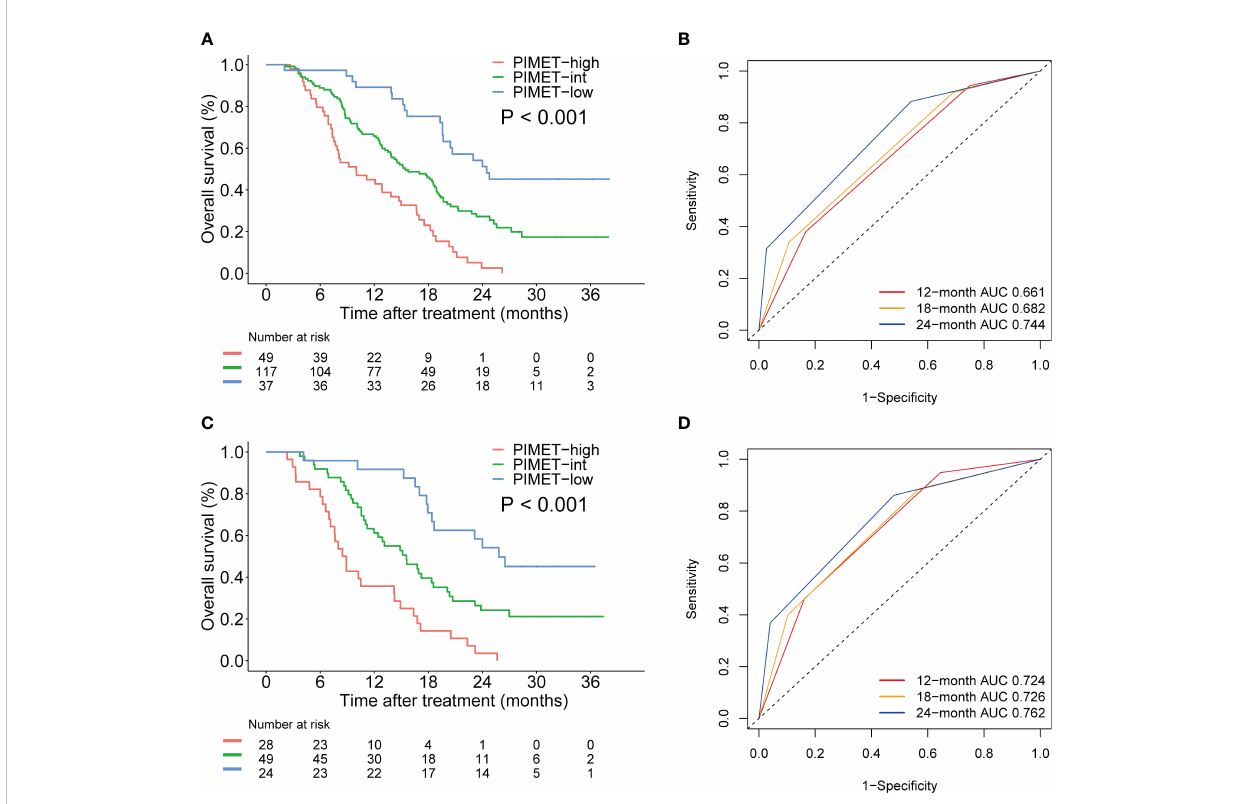
FIGURE 2 The prognostic ef fi ciency of PIMET score for patients receiving lenvatinib monotherapy or lenvatinib plus ICI for unresectable HCC. (A) The Kaplan- Meier survival curves of OS according to PIMET score in the training cohort. (B) The AUCs of PIMET score for predicting 12-, 18-, and 24-month OS in the training cohort. (C) The Kaplan-Meier survival curves of OS according to PIMET score in the validation cohort. (D) The AUCs of PIMET score for predicting 12-, 18-, and 24-month OS in the validation cohort. AUC, area under the receiver-operating characteristic curve; HCC, hepatocellular carcinoma; OS, overall